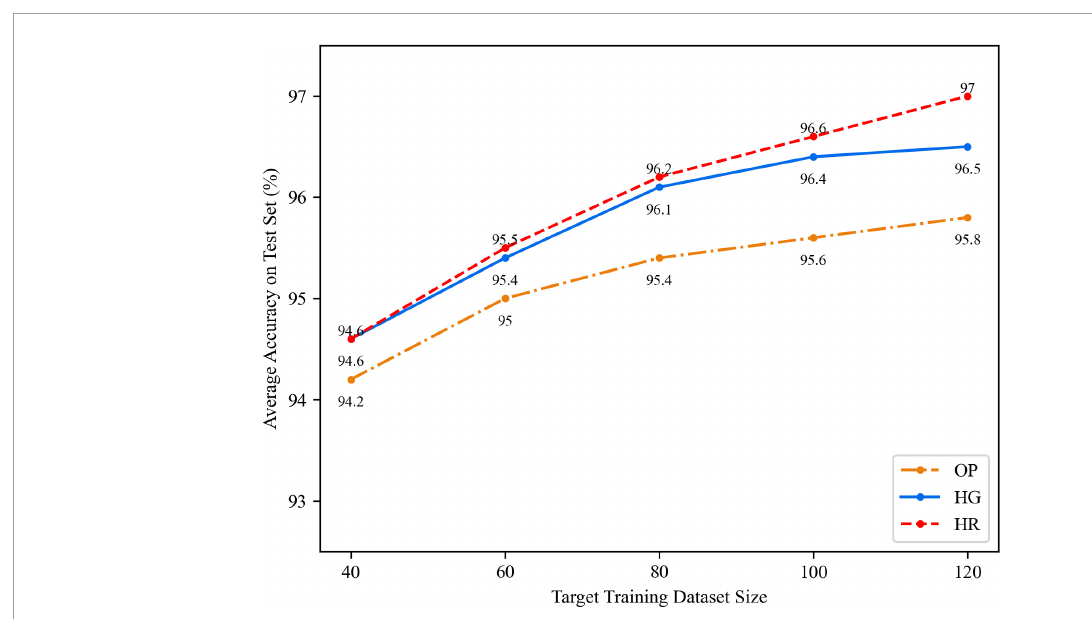
FIGURE8 The average accuracy on each key point in the mean 3D way.